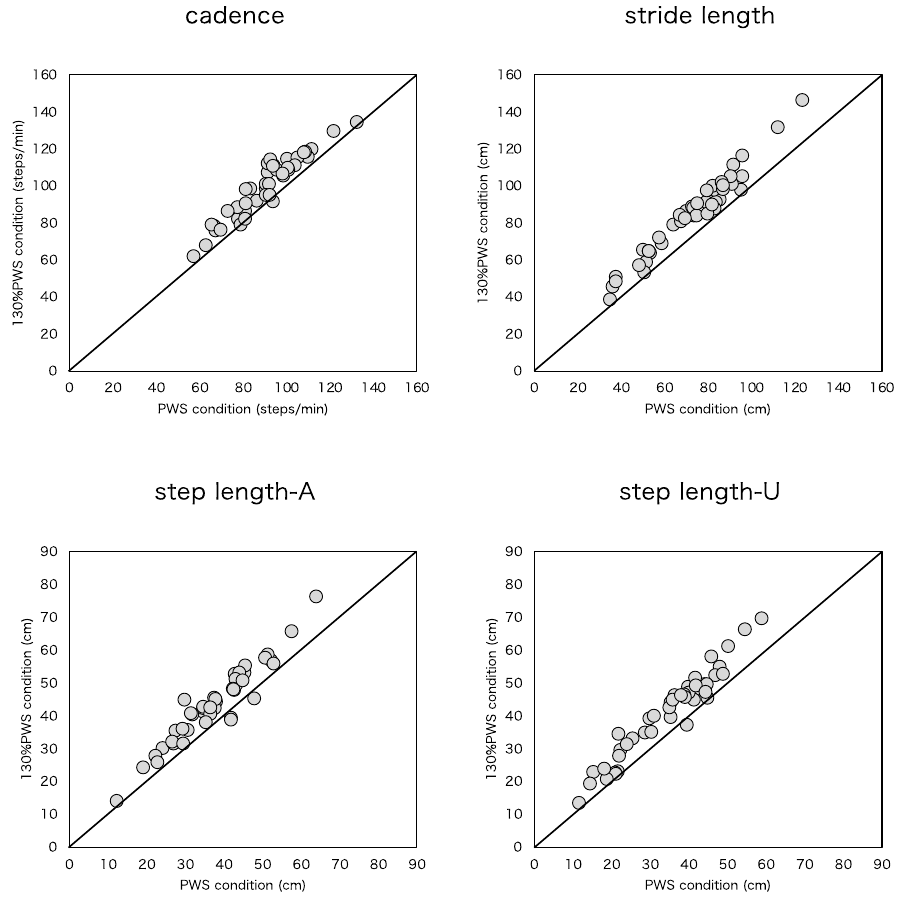
Figure 1 Scatter plot of distance parameters and cadence for PWS condition versus 130%